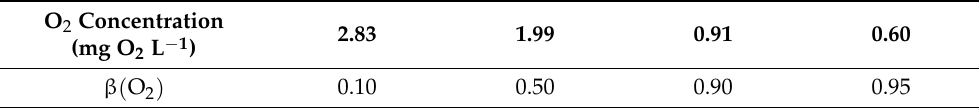
Table 3. Survivorship β ( O 2 ) of Aurelia coerulea polyps at different dissolved oxygen concentrations; estimated using the median sublethal concentration (SLC 50 ) of mollusks, which would competitively occupy the substrate that would otherwise be available to cnidarians.